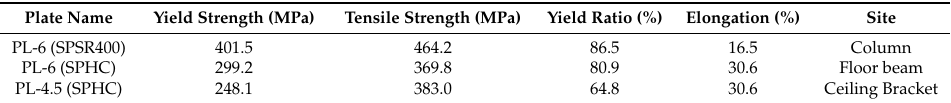
Table 4. Results of a tensile